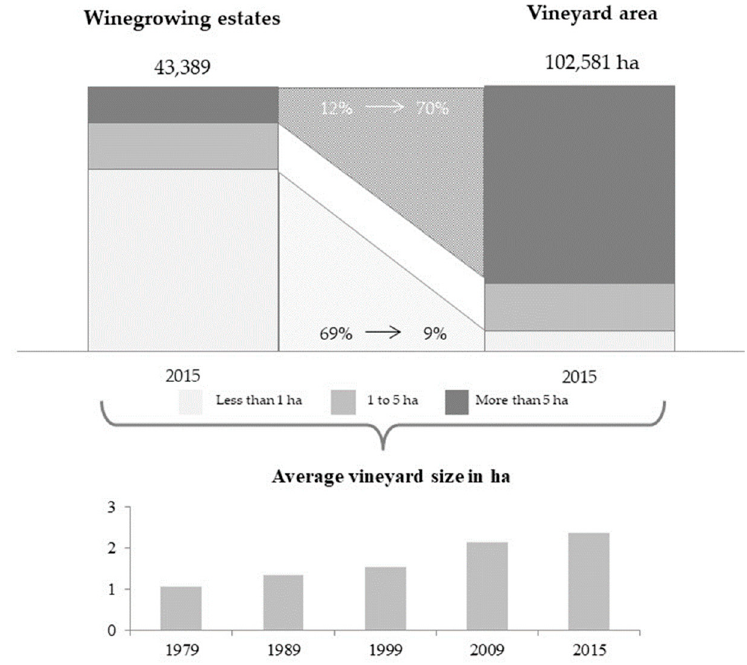
Figure 3. German wine production (number of producers and hectares) [70,79,84–87].